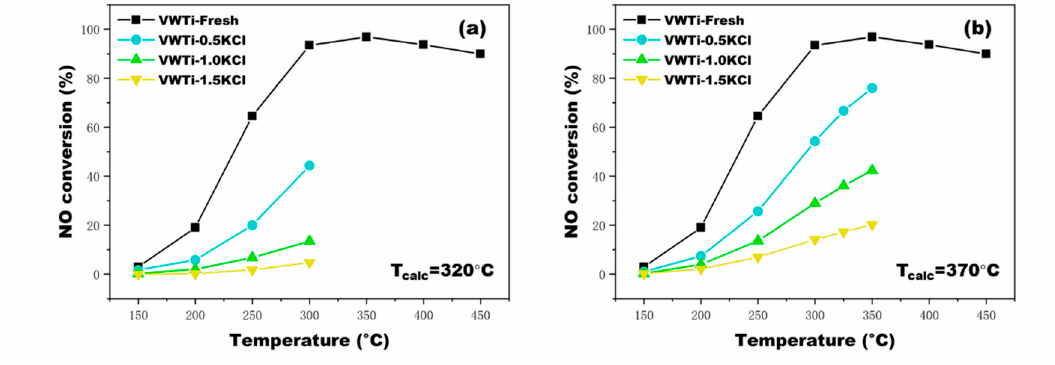
Figure 1. Effects of three n(K)/n(V) ratios on activity of V 2 O 5 -WO 3 /TiO 2 catalyst calcinated at: ( a )320 °C; and ( b ) 370 °C.